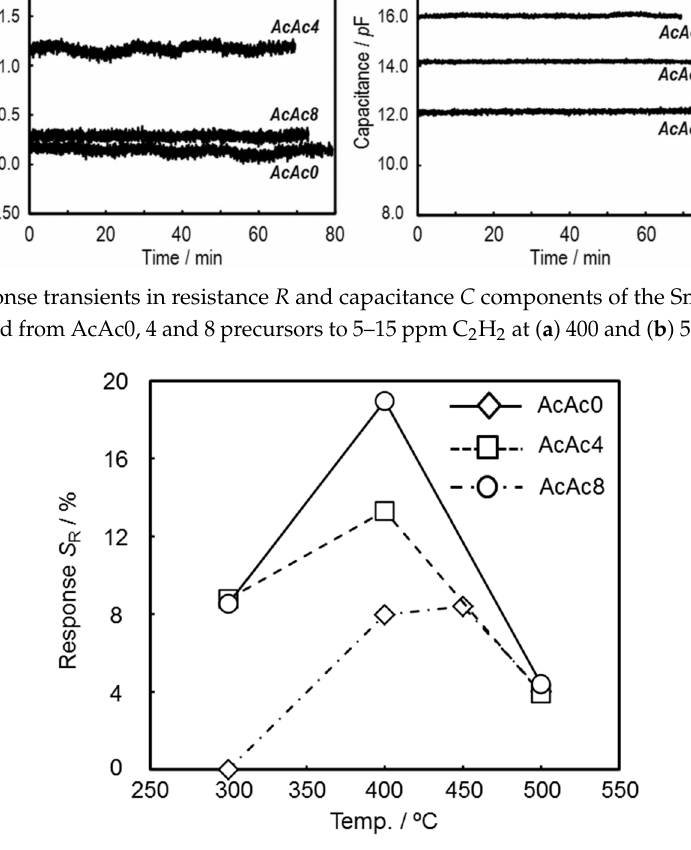
Figure 10. Temperature dependencies of S R for the SmFeO 3 devices at 5 ppm C 2 H 2 at 20 kHz.